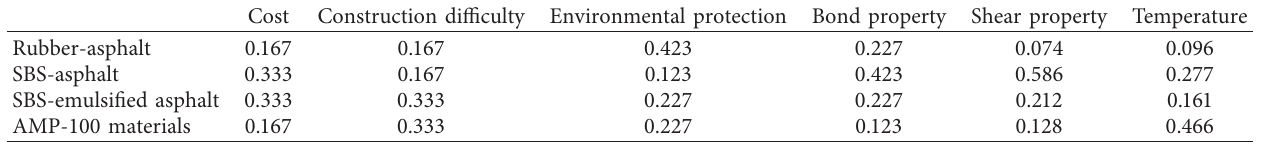
Table 8: Priority normalization of the waterproof adhesive layer under various influencing factors.